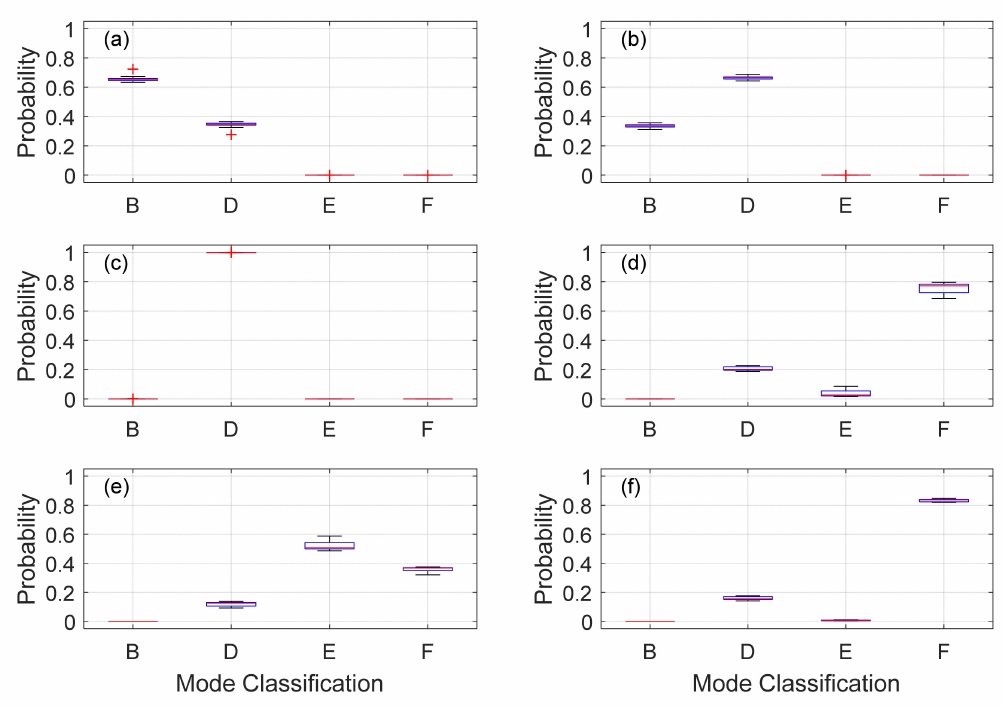
Figure 19. Mode-shape probability predictions of the accelerometer frequencies on Day 1 for peaks around ( a )—150 Hz, ( b )—220 Hz, ( c )—350Hz, ( d )—490 Hz, ( e )—500 Hz, and ( f )—550 Hz.